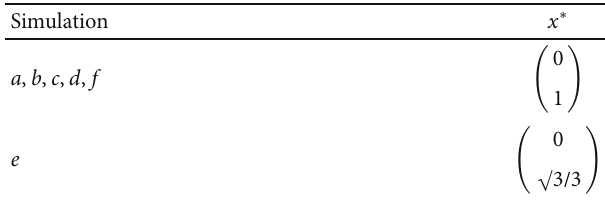
Table 4: Experiment 1: solution of problem (7), given by Algorithm in [2].